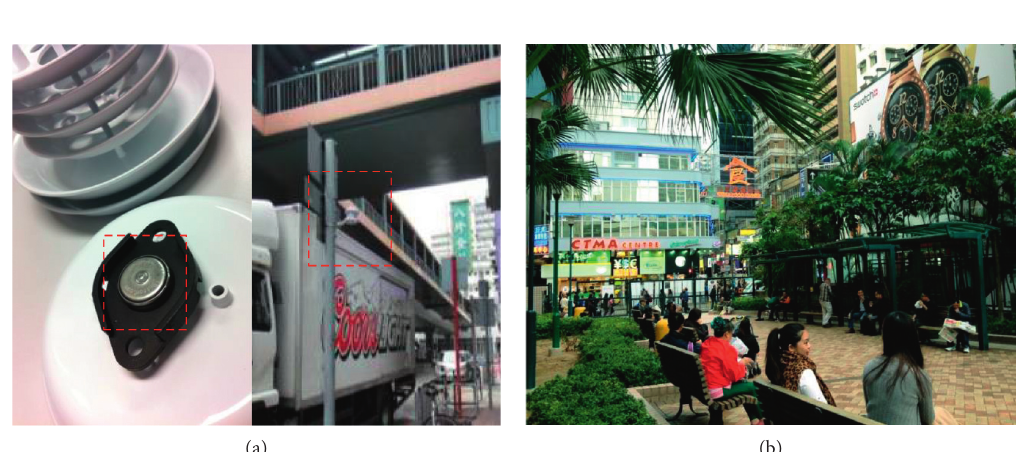
Figure 2: The photographs showing (a) an iButton sensor and a shielded temperature sensor mounted on a street signpost and (b) a small pocket park setting with limited vegetation at point